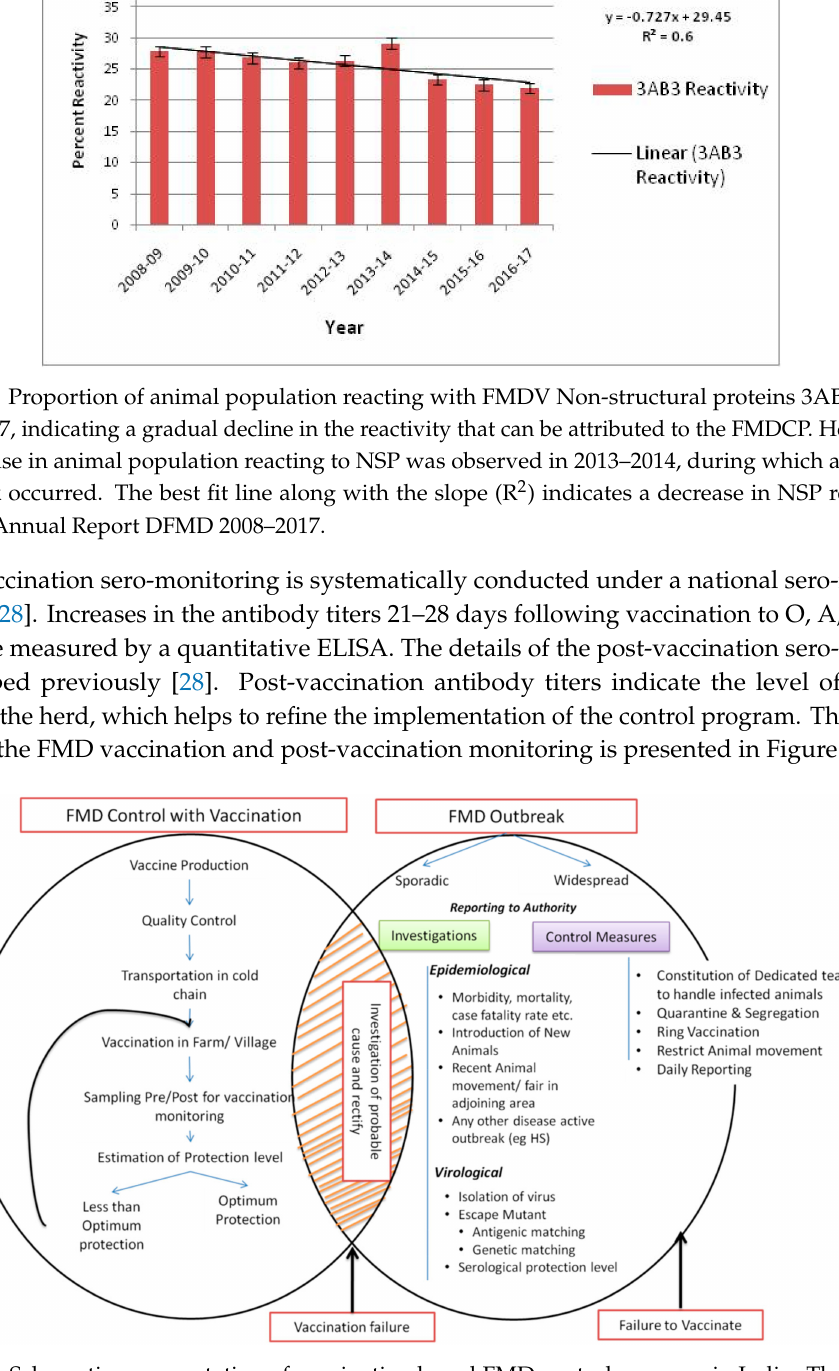
Figure 5. Schematic representation of vaccination based FMD control program in India. The figure describes the general procedure of vaccination and post vaccination monitoring and measures to be adopted for the investigation of FMD